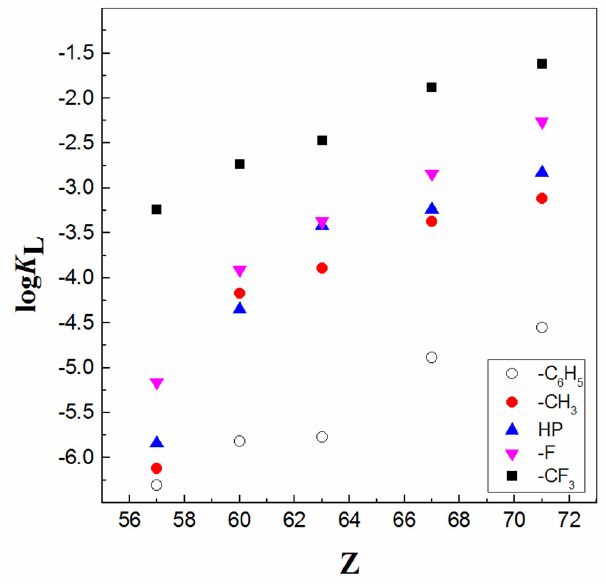
Figure 11. Log K L of various 4-acylpyrazolones (diluent CHCl 3 ) vs. atomic number Z of La, Nd, Eu, Ho and Lu. Table 6. Recommended data for the synergistic solvent systems of 4-acyl-pyrazolone and calixarenes.